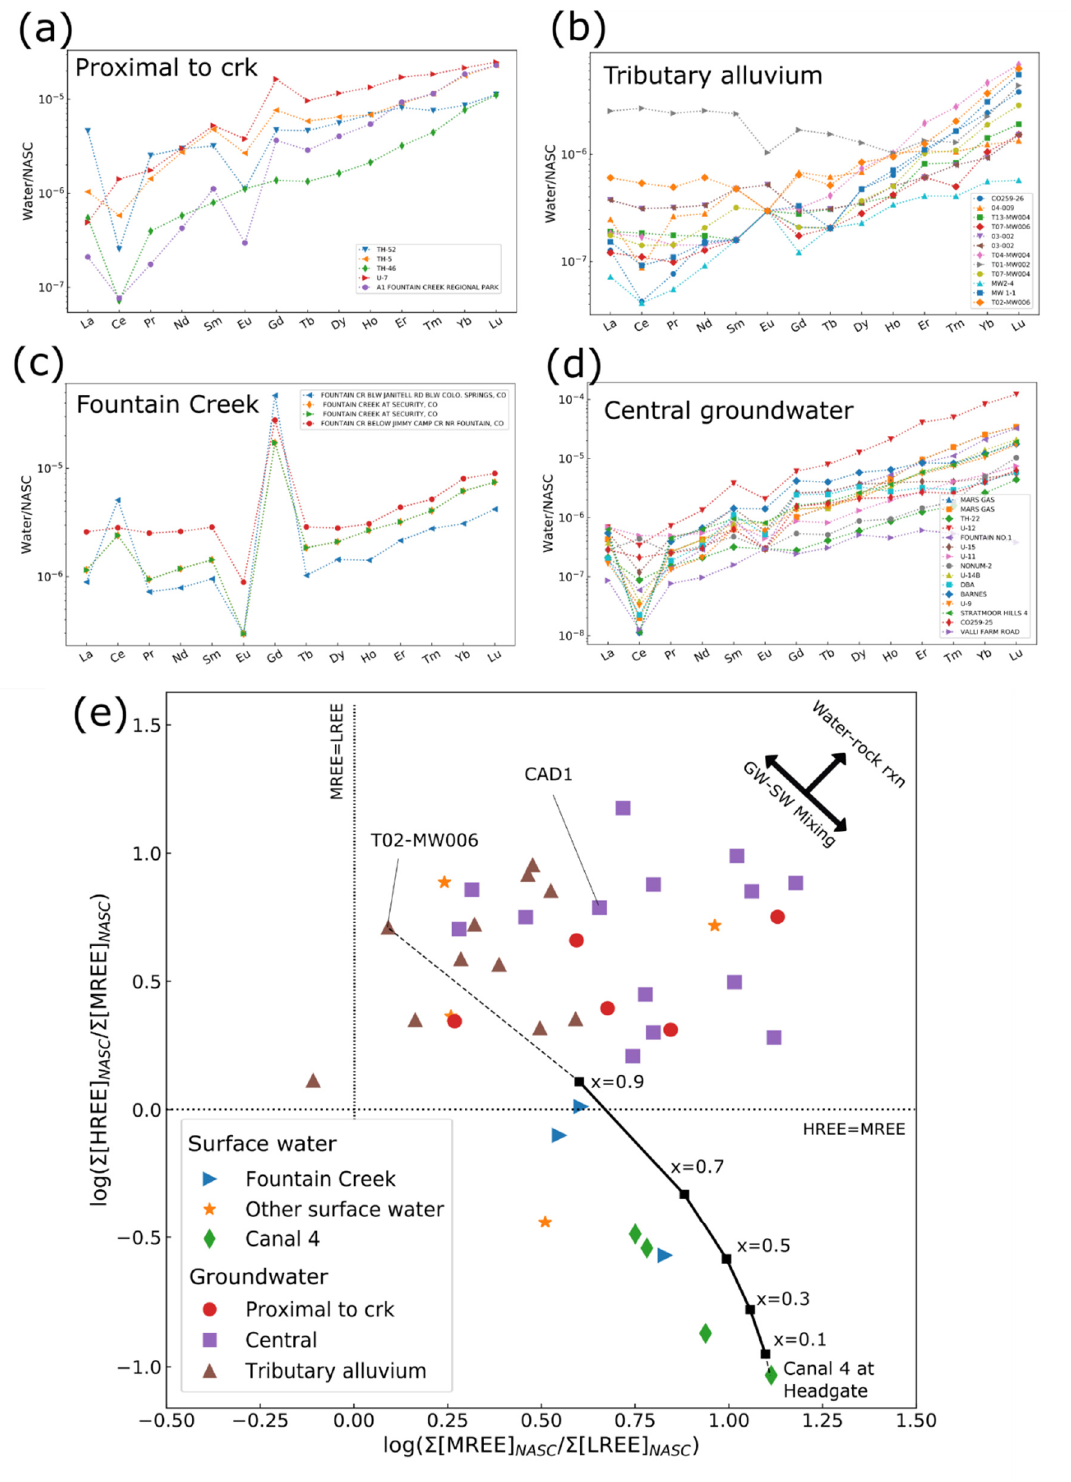
Figure 4. ( a ) Evaluation of rare earth element (REE) concentrations in groundwater (GW) and surface water (SW). Panels ( a – d ) show REE concentrations normalized to North American Shale Composite (NASC). Prominent Gd anomalies are present in Fountain Creek and groundwater proximal to the creek. Panel ( e ) shows a REE normalization plot (e.g., see Reference [92]) and conceptual mixing relations. A synthetic mixing line between groundwater composition (T02-MW006) and WWTP-affected surface water (Canal 4 at Headgate) is labeled with the fraction of groundwater in the mixture (x). Arrows at top right of REE normalization diagram indicate the general patterns expected by mixing relations and water– rock reaction (rxn).